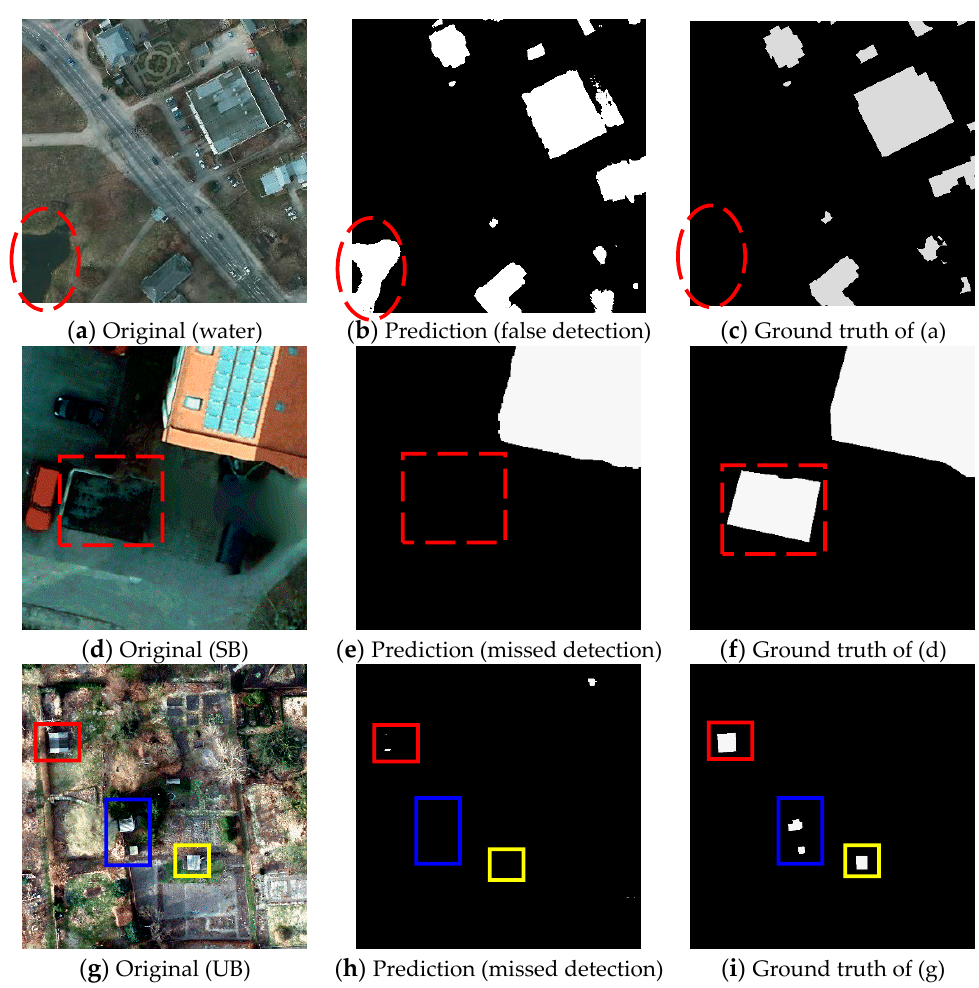
Figure 7. Some factors caused false detection and missed detection in building extraction. ( a ) represents the original red–green–blue (RGB) image with water; ( b ) represents the corresponding prediction with false detection; ( c ) represents the corresponding ground truth. ( d – f ) and ( g – i ) are the original RGB image with special buildings and unremarkable buildings, corresponding prediction with missed detection, and the corresponding ground truth, respectively.